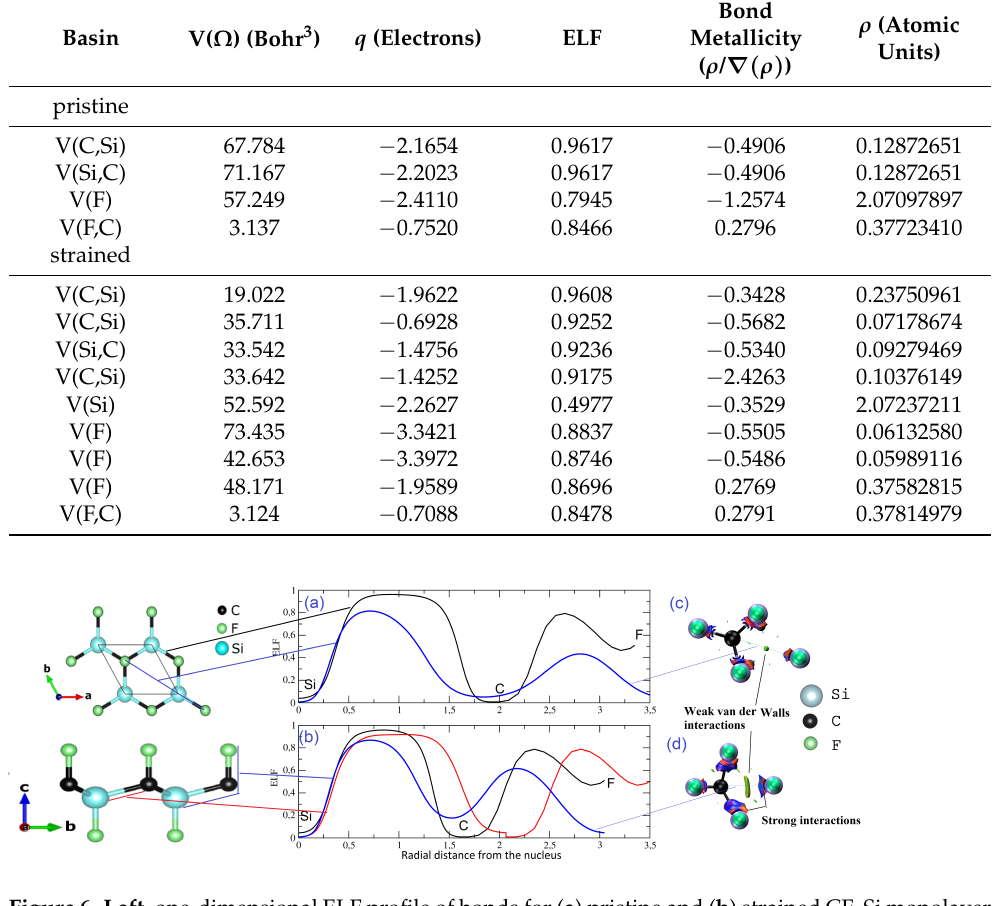
Figure 6. Left , one-dimensional ELF profile of bonds for ( a ) pristine and ( b ) strained CF 2 Si monolayer. The black, blue, and red correspond, respectively, to Si–C–F, deformed Si–C–Si for strained structure, and Si–C–F lateral direction. Right, the noncovalent interactions index NCI = 0.3 isosurface of ( c ) pristine and ( d ) strained